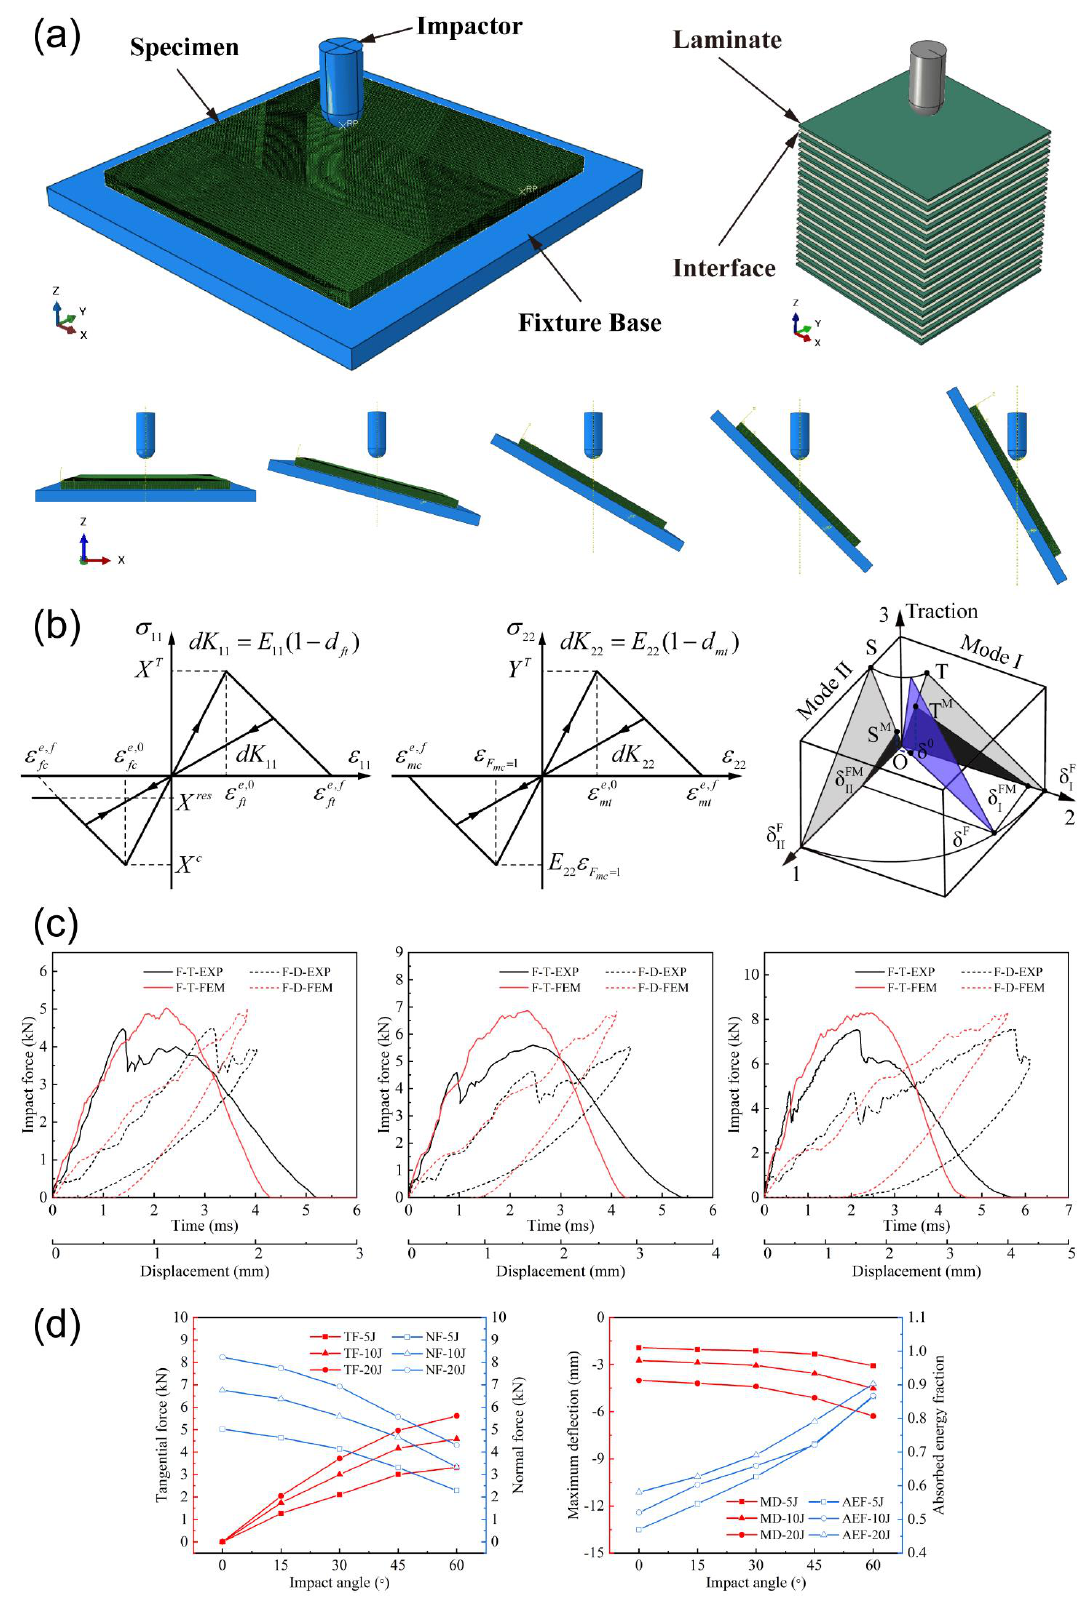
Figure 1. Numerical simulation of oblique impact: ( a ) impact model with different impact angles, ( b ) intralaminar stress–strain relationship and cohesive zone model under mixed-mode loading, ( c ) validation of numerical model, and ( d ) overall numerical results of impact